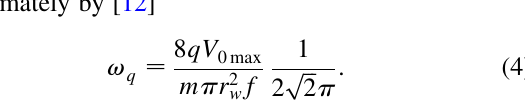
FIG. 2. Plot of voltage waveform amplitude V the compression experiments. During the characteristic time scale (cid:4) , about 80% of the transition is